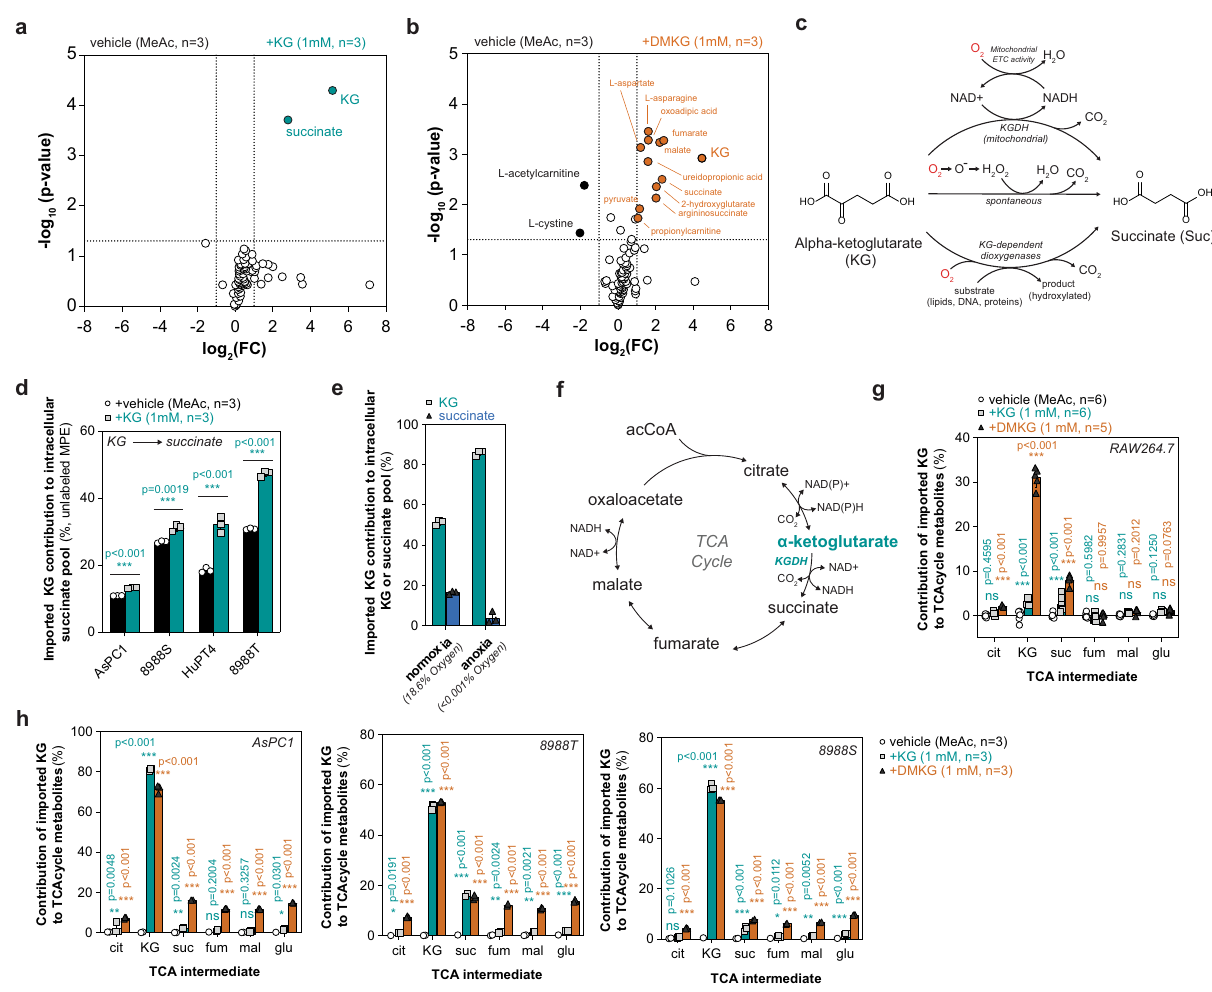
Fig. 5 KG utilization by cells and spurious metabolic effects of DMKG. a , b Volcano plot of metabolomic changes in 8988T cells treated with methyl acetate or 1 mM of KG or DMKG for 3 h. a Only KG and succinate were signi fi cantly increased in KG-treated cells, whereas 14 metabolite levels changed signi fi cantly in response to DMKG treatment in ( b ). Metabolite changes were considered signi fi cant if log 2 fold change (FC) was ≥ 1 or ≤ − 1 and adjusted p value < 0.05; signi fi cance was determined using the Wald test (DESeq2) corrected for multiple comparisons. c Schemati c depicting possible metabolic routes of KG decarboxylation to succinate (Suc). Mitochondrial KG dehydrogenase (KGDH) catalyzes the NAD + -dependent oxidative decarboxylation, producing NADH which fuels ETC activity. KG can oxidatively decarboxylate to Suc in the presence of cellular hydrogen peroxide, which can be produced from superoxide free radicals. KG can participate in hydroxylation reactions catalyzed by the large family of KG-dependent dioxygenases, which decarboxylate KG to Suc. d Contribution of imported KG to succinate pools quanti fi ed by measuring %(100-MPE) of succinate labeling from 13 C 5 - glutamine in AsPC1, 8988S, HuPT4, and 8988T cells cultured for 24 h. Data are mean ± s.d., n = 3 biologically independent samples; signi fi cance determined by two-tailed Student ’ s t -test corrected for multiple comparisons, *** p < 0.0001. e Contribution of imported KG to intracellular KG and succinate pools in 8988T cells cultured in normoxic (18.6% oxygen) or anoxic (<0.001% oxygen) conditions for 24 h with 13 C 5 -glutamine with or without 1 mM KG; normoxic data plotted from Fig. 5h. Data are plotted as the difference in %MPE from 13 C 5 -glutamine between KG-supplemented and control (MeAc) conditions, mean ± s.d., n = 3 biologically independent samples. f Schematic depicting reactions o f the mitochondrial TCA cycle including KGDH; acetyl-CoA (acCoA). g , h Contribution of imported KG or DMKG to mitochondrial TCA cycle intermediates, including succinate (suc), fumarate (fum), malate (mal), glutamate (glu), and citrate (cit). Percent contribution calculated by measuring the difference in %MPE from 13 C 5 -glutamine between KG- or DMKG- supplemented and control (MeAc) conditions in RAW264.7 macrophages ( g ) or AsPC1, 8988T, and 8988S pancreatic cancer cells ( h ) cultured for 24 h with or without 1 mM unlabeled KG. Data are mean ± s.d., n = 3 biologically independent samples; signi fi cant determined by two-way ANOVA using Dunnett ’ s multiple comparisons test, n.s. p > 0.05, * p < 0.05, ** p < 0.01, *** p <